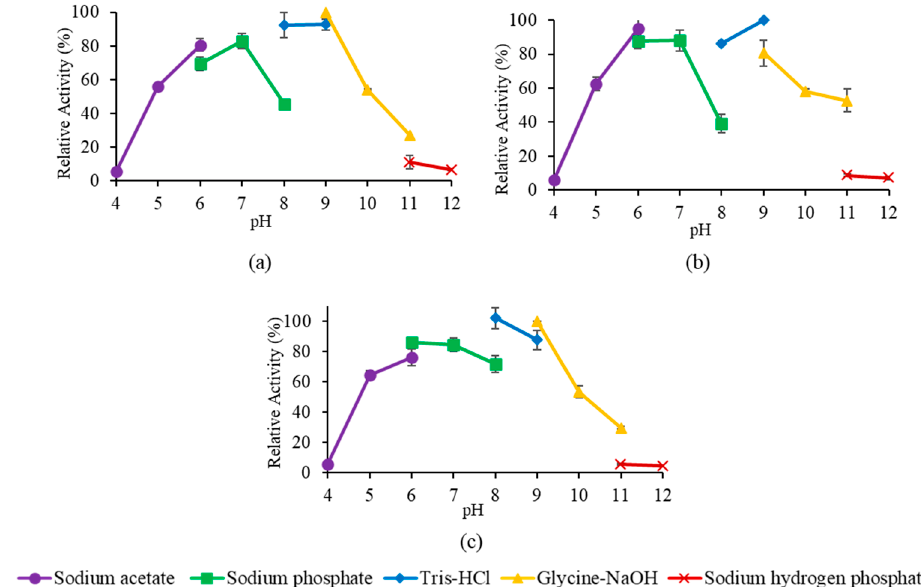
Figure 9. pH stability profile of mutant lipases. ( a – c ) stability profile of A8V, A8P and A8E, respectively.